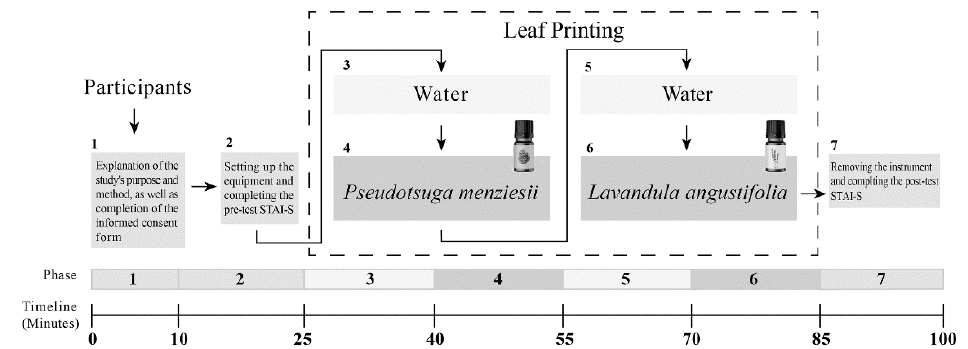
Figure 1. The procedure of the